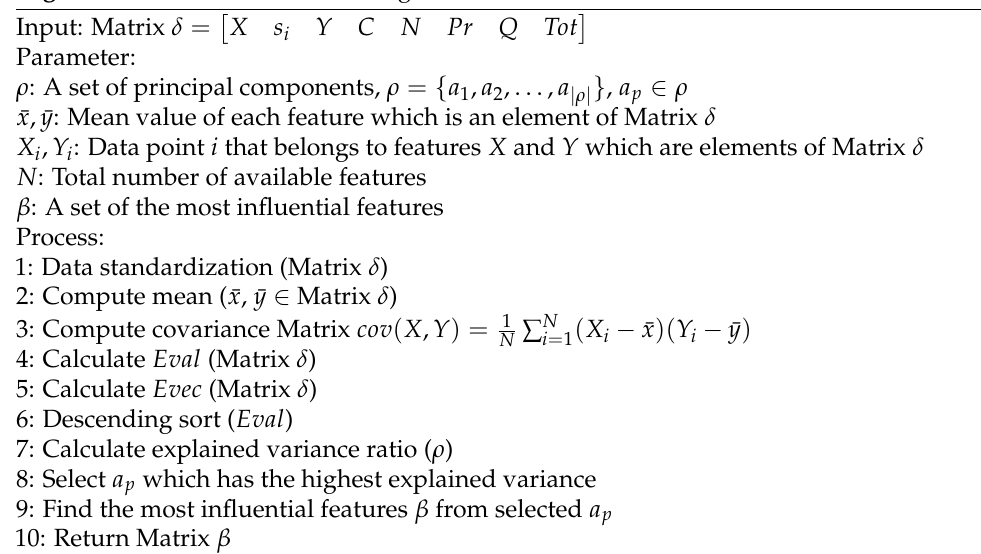
Algorithm 1 Feature selection using